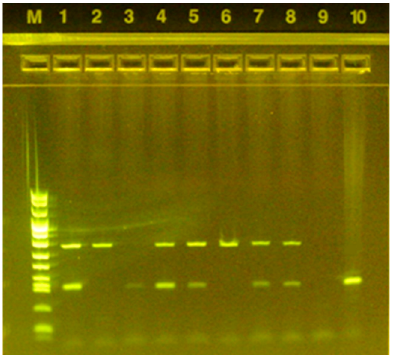
Figure 2. Agarose gel electrophoresis following multiplex PCR amplification of DNA samples extracted from taeniid eggs. Lane M: marker; lanes 2 and 6: Taenia spp. positive samples; lane 3 E.